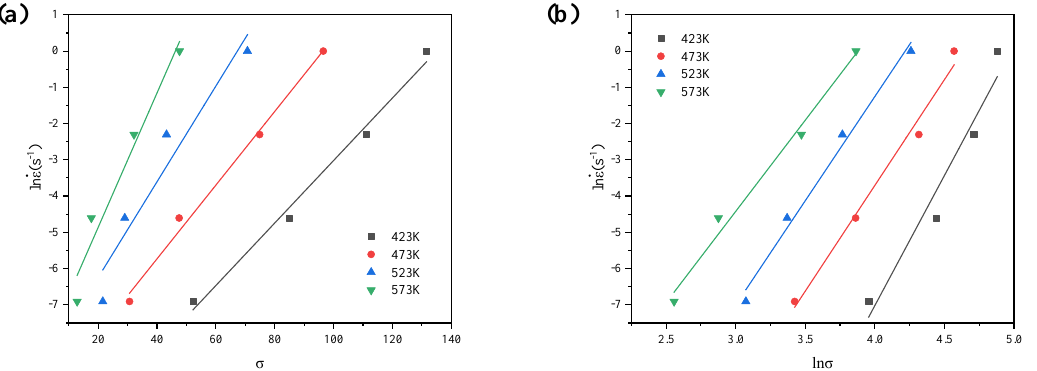
where A 1 , A 2 and A are constants related to the material composition but independent of temperature. The material constants α , A , n and Q calculated with regression of data obtained from compression experiments, and they are all related to strains [28,40]. In this study, we use a 0.3 strain value to demonstrate how to calculate material parameters. Based on the experimental results and Equations (4) and (5), the values of n’ and β can be obtained . . ε ~ln σ and ln ε ~ σ relations as shown in Figure 5, then we calculate the average value of by ln slope after linear fitting, n’ = 5.95 and β = 0.126.